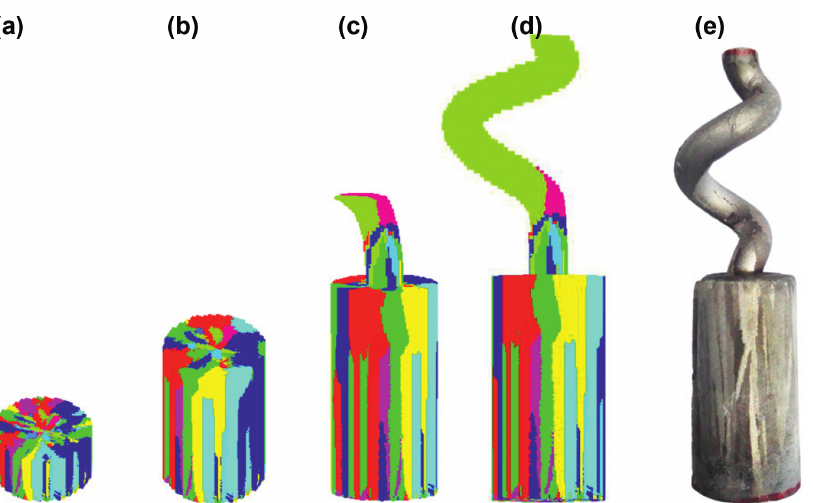
Figure 6: Simulation and experimental results of the grain structure for the HRS process: (a) t = 30 s; (b) t = 60 s; (c) t = 90 s; (d) t = 180 s; and (e) experimental